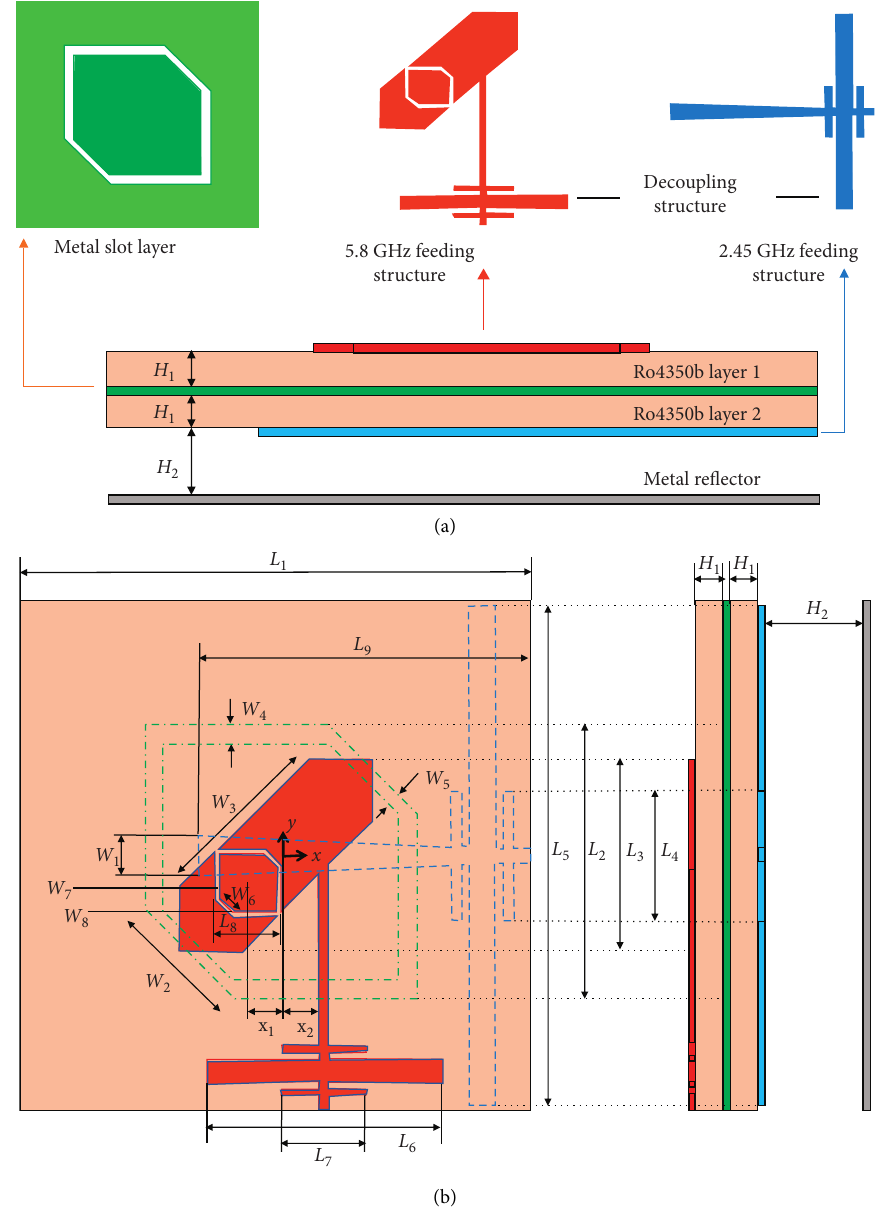
Figure 1: Antenna structure: (a) stack-up structure; (b) top view and side